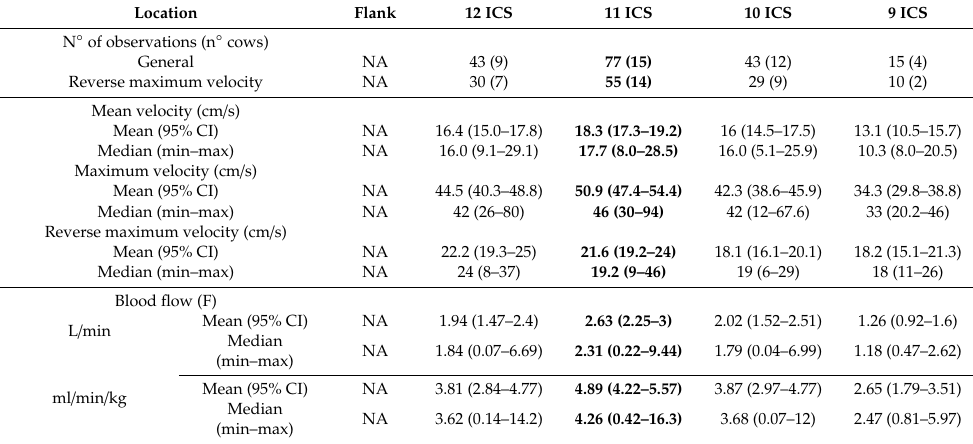
Table 4. Results of ultrasonography examination of the intrahepatic portal veins expressed as mean (95% CI) and median (minimum–maximum). Values obtained in the most frequent location are highlighted in